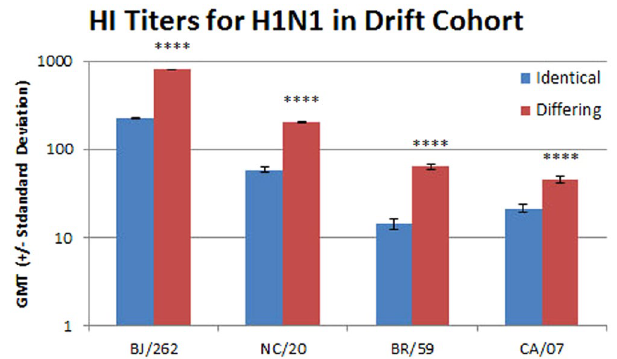
Figure 2. The geometric mean titers for sera from the identical and differing groups in the drift cohort for H1N1 viruses are shown with standard deviations. The viruses used are listed on the x axis: BJ/262, A/ Beijing/262/1995 (H1N1); NC/20, A/New Caledonia/20/1999 (H1N1); BR/59, A/Brisbane/59/2007 (H1N1); and CA/07, A/California/07/2009 (pdmH1N1). The difference between the identical and differing groups was evaluated using the Mann Whitney rank test. **** p <